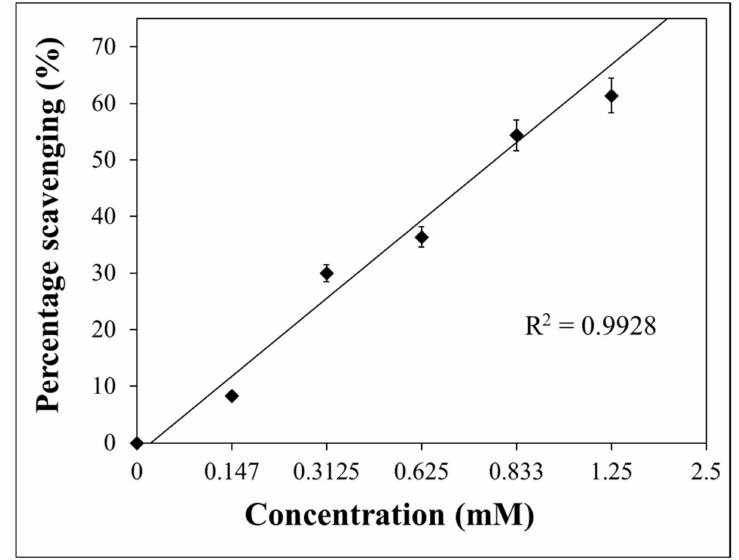
Figure 8. Percentage inhibition for blackberry extract in ABTS + scavenging